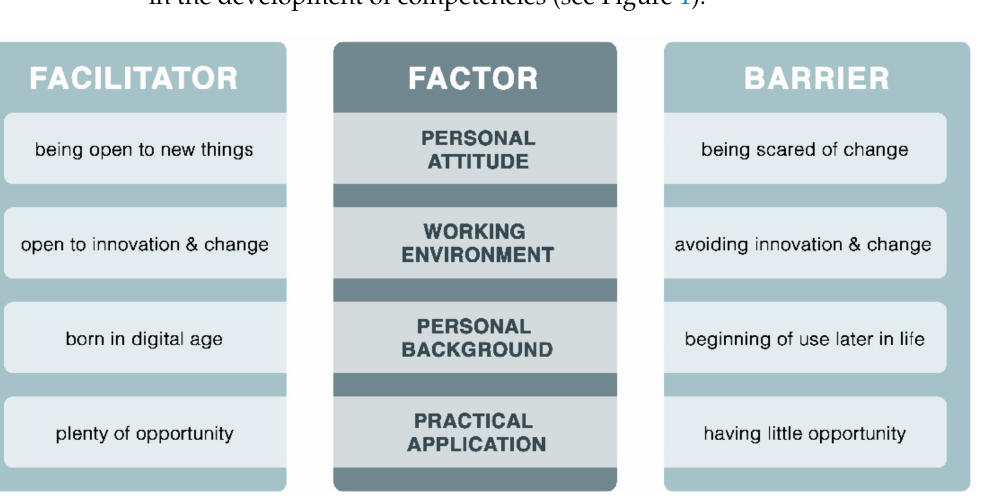
Figure 1. Factors influencing the development of competencies in the field of